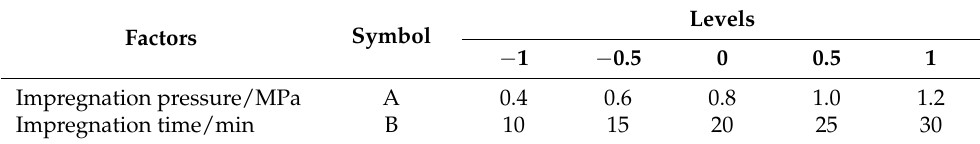
Table 1. Test factors and level schedule for